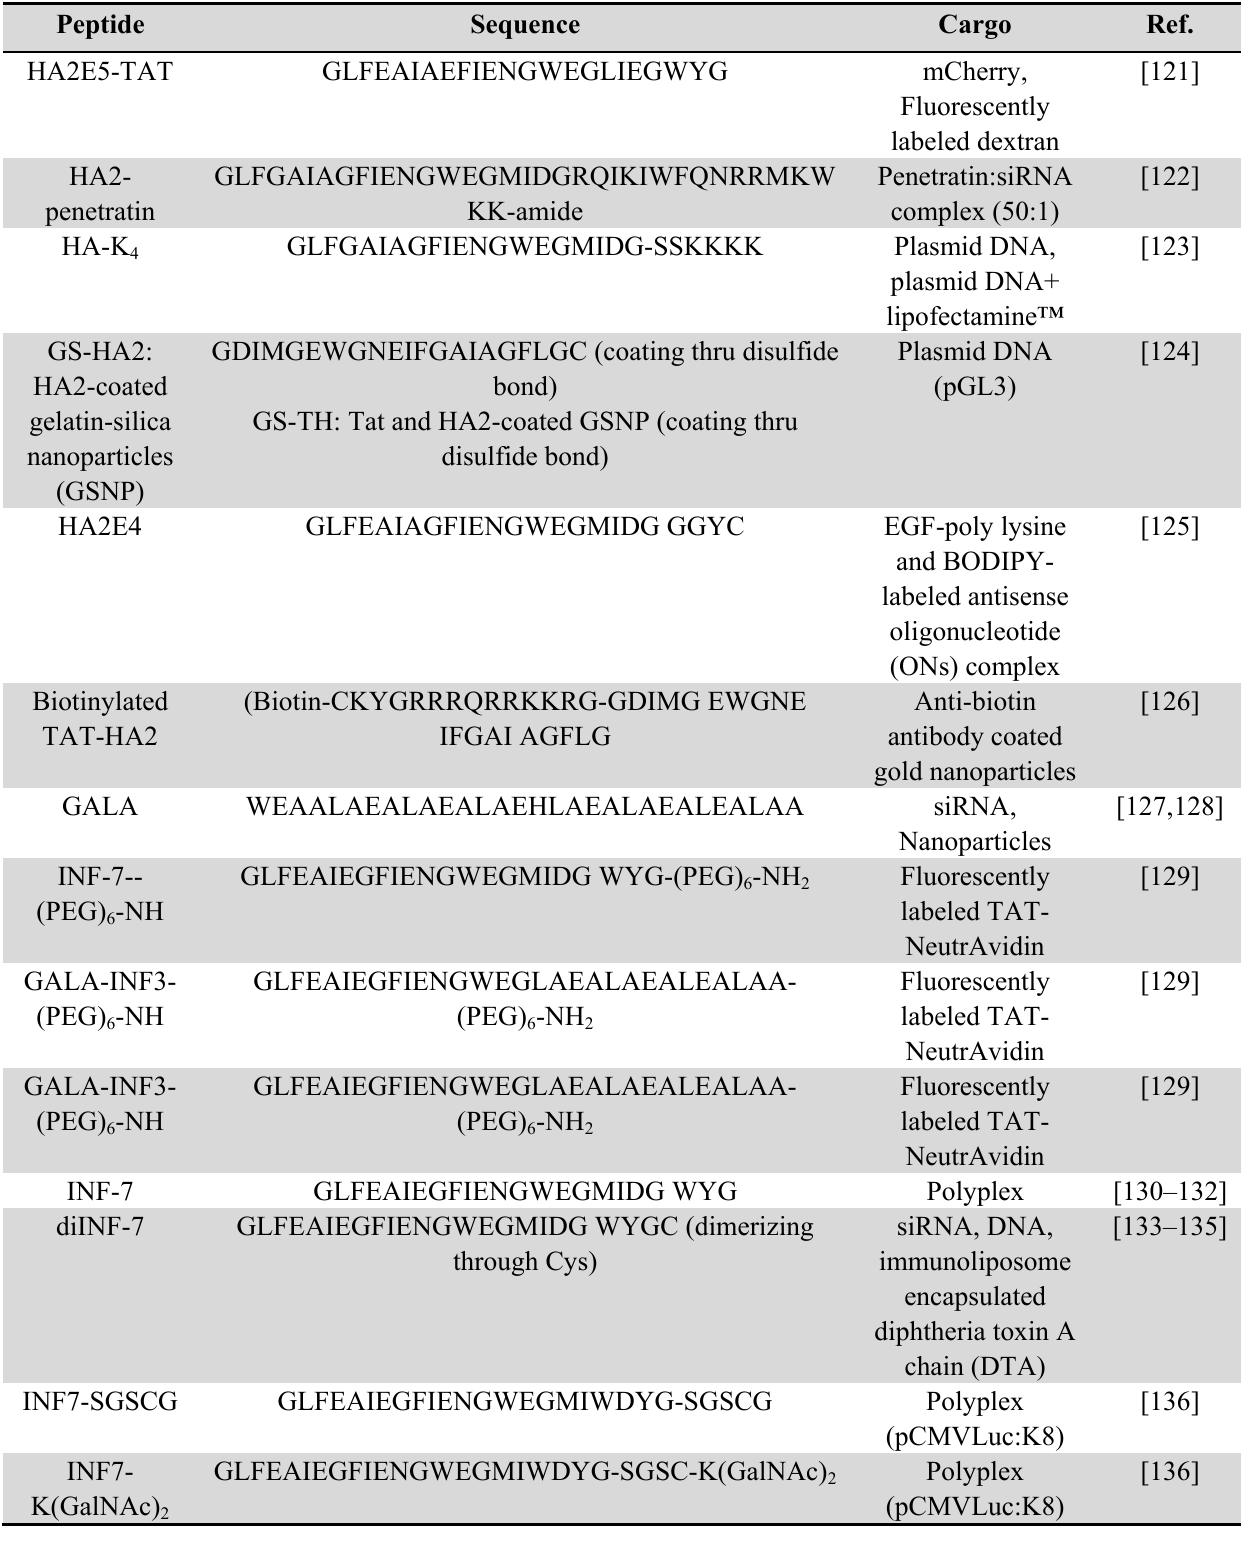
Table 1. Examples of PMAPs that increase endosomal escape of